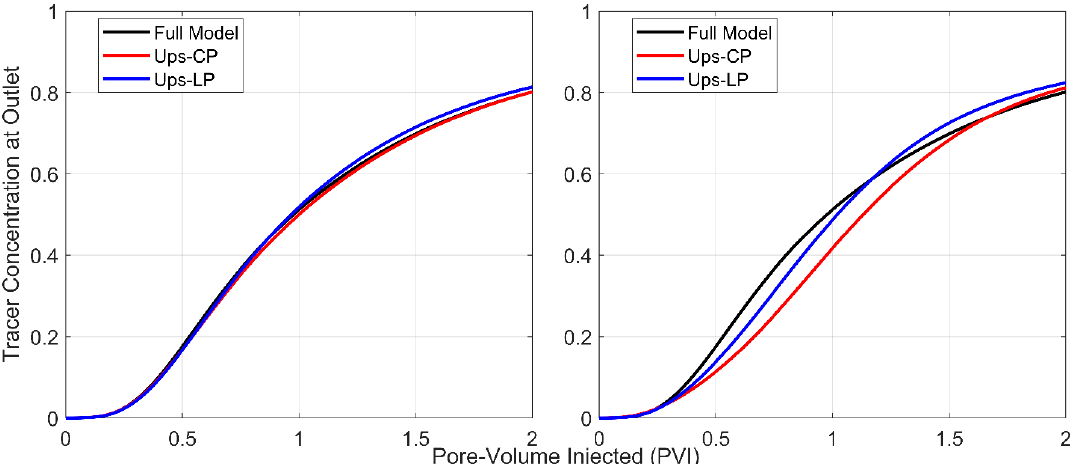
Figure 8. Absolute error of the tracer concentration solutions after 2 PVI for the Ups-CP ( first column ) and Ups-LP ( second column ) models when the partition is (cid:1864) p = (cid:1864) g ( first row ) and (cid:1864) p = 8 × (cid:1864) g ( second row ).